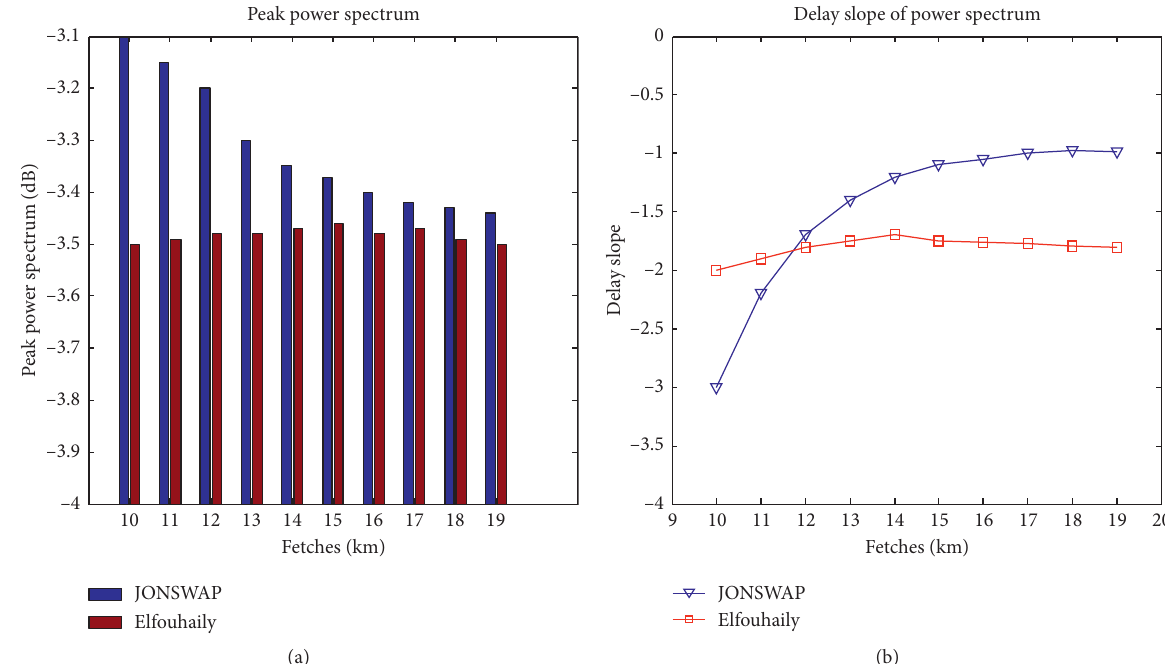
Figure 3: Comparison of peak power and delay slope of power spectrums under different